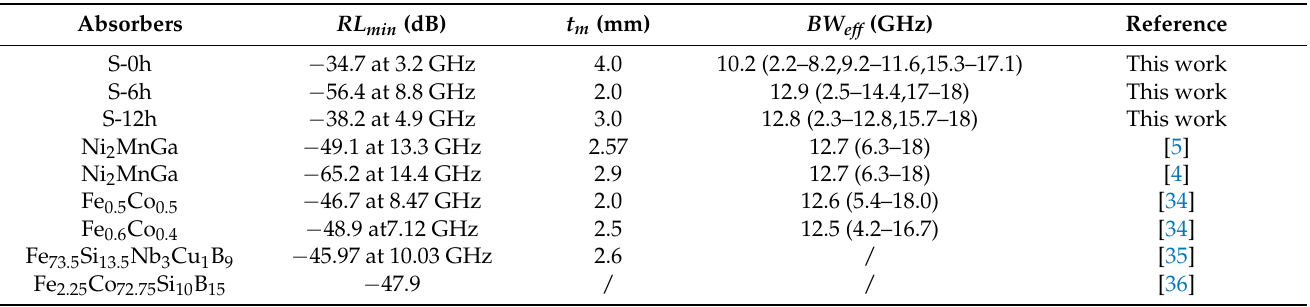
Table 1. A comparison with the microwave absorption parameters of the typical ferromagnetic MAMs with paraffin matrix.